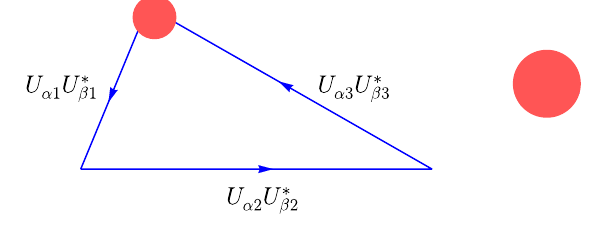
the exact unitarity triangle of three active neutrinos defined by Eq. (1); and pattern b1 , b2 or b3 stands for a unitarity polygon of ( 3 + n ) neutrinos defined by Eq. (3)